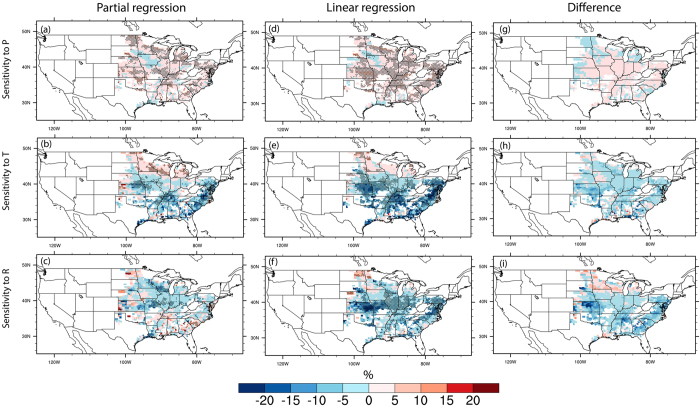
Same as Fig. 3 but for soybean yields.Figure was created by NCAR Command Language58.